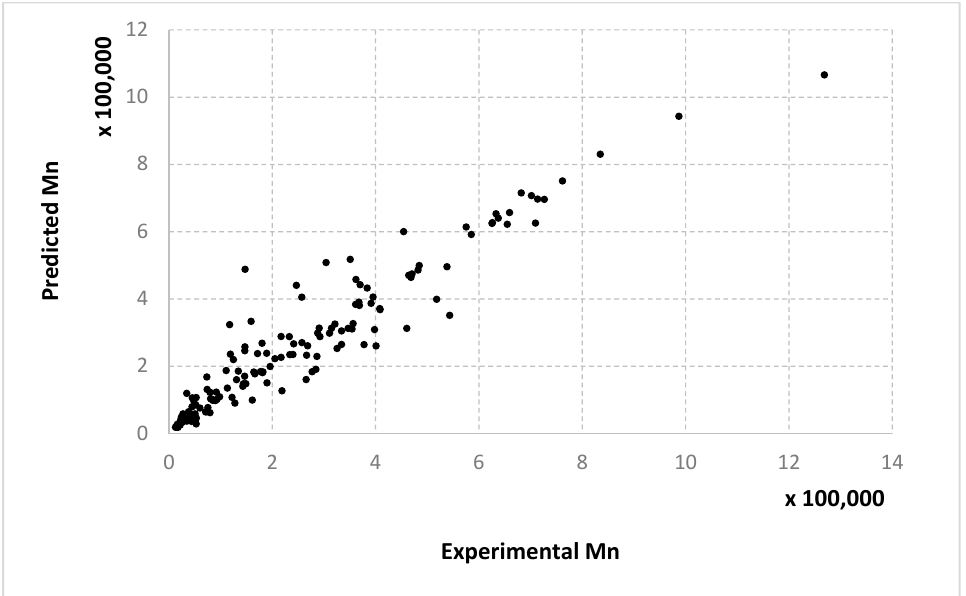
Figure 9. Predicted numerical average molecular weight with the RADIAN algorithm versus ex- perimental data, setting 2, with data split into 10% for training and 90% for testing.